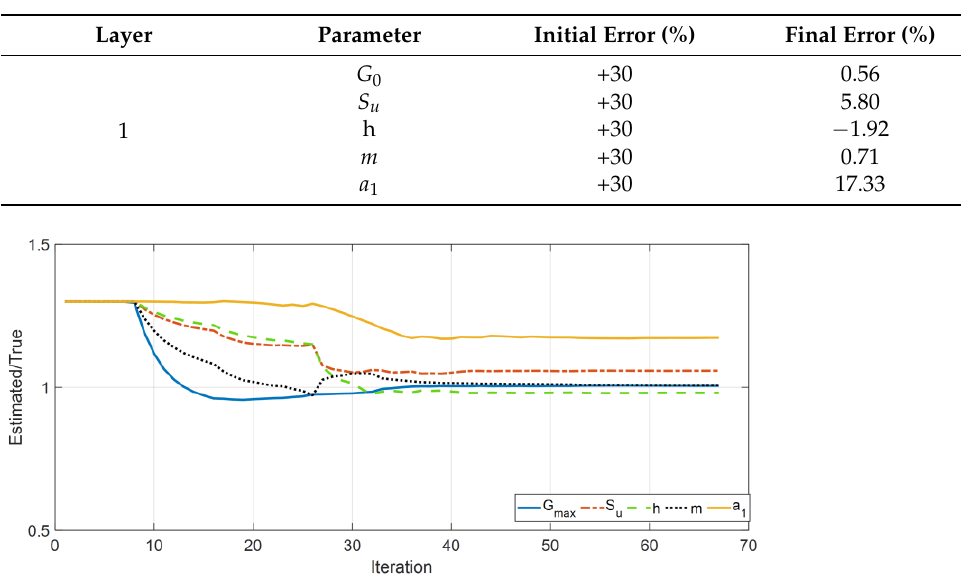
Table 2. The initial and final error of estimation parameters for Case Study 3.